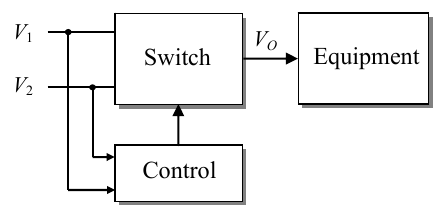
Figure 1. Schema of dual power source switching.